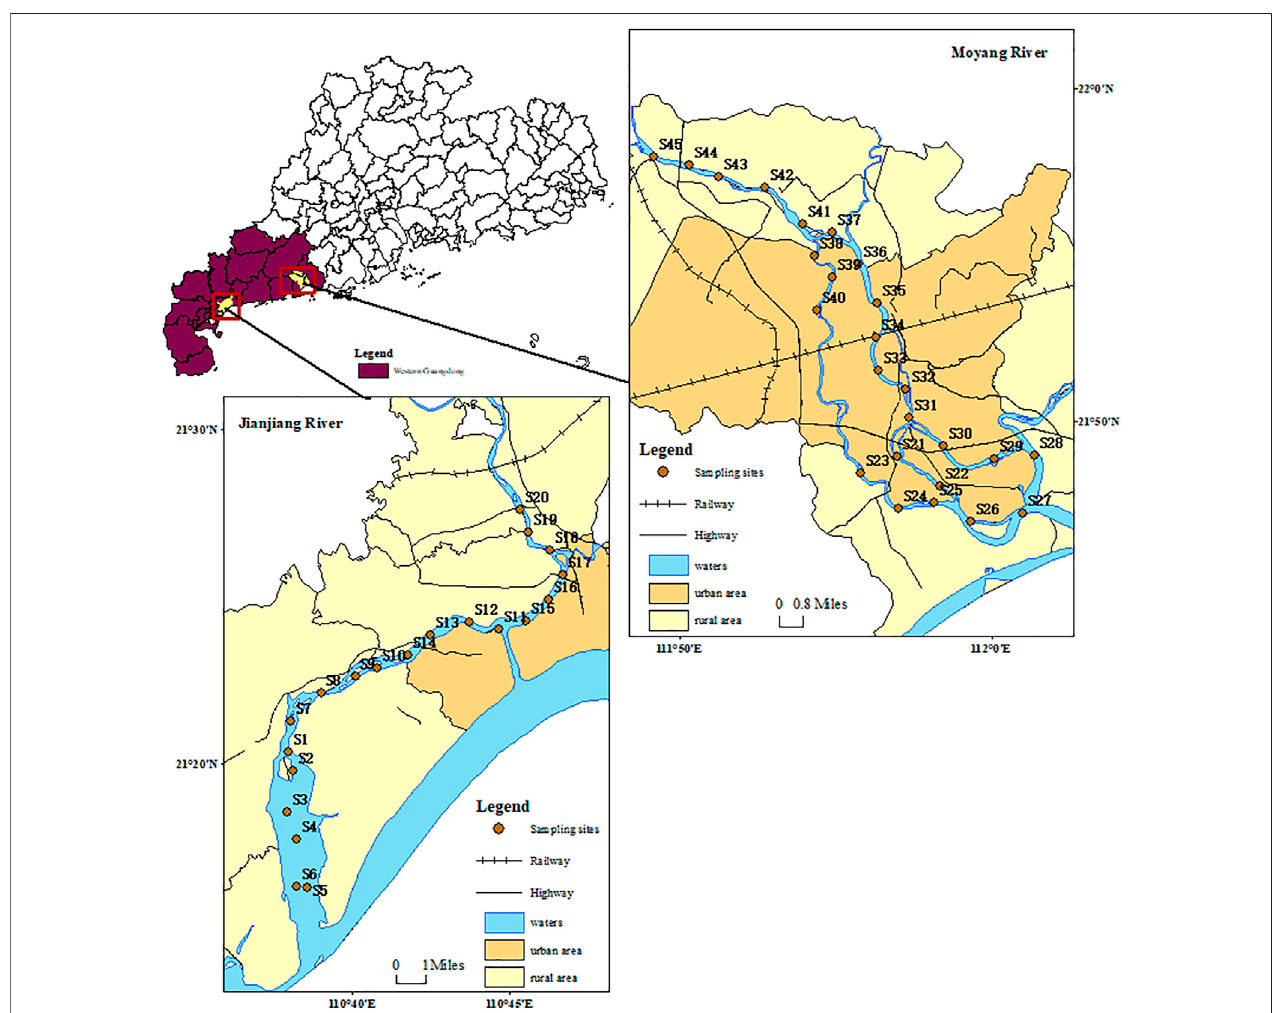
FIGURE 1 | Locations of sampling sites of surface sediments in Jian and Moyang river basins.